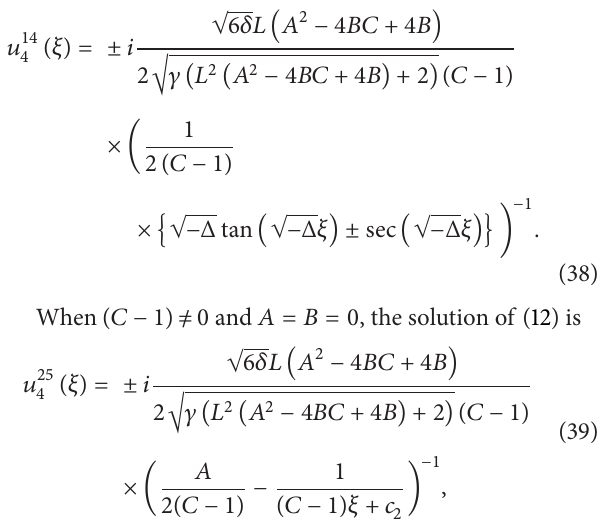
When Δ = 𝐴 2 − 4𝐵𝐶 + 4𝐵 < 0 and 𝐴(𝐶 − 1) ̸= 0